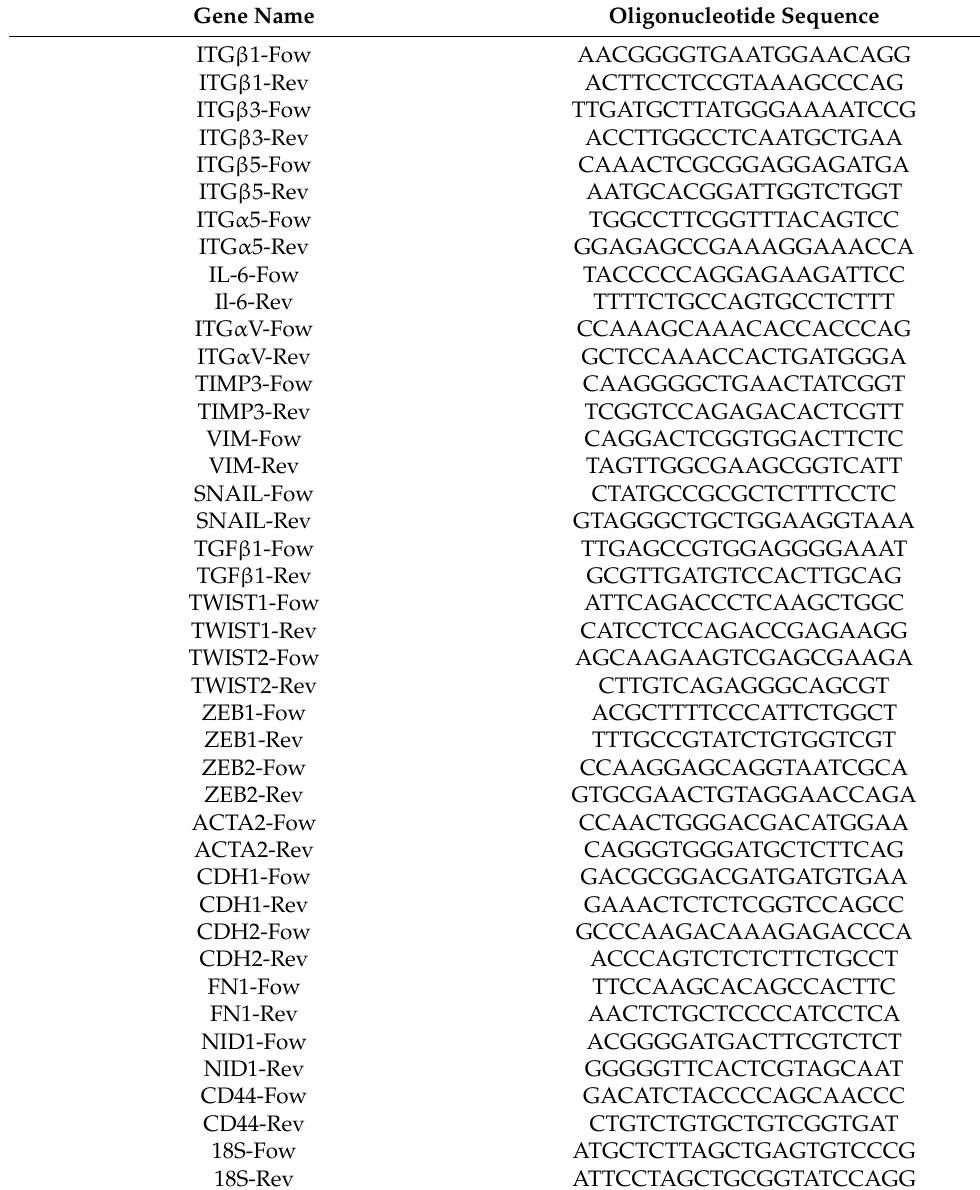
Table 1. List of primers used in this